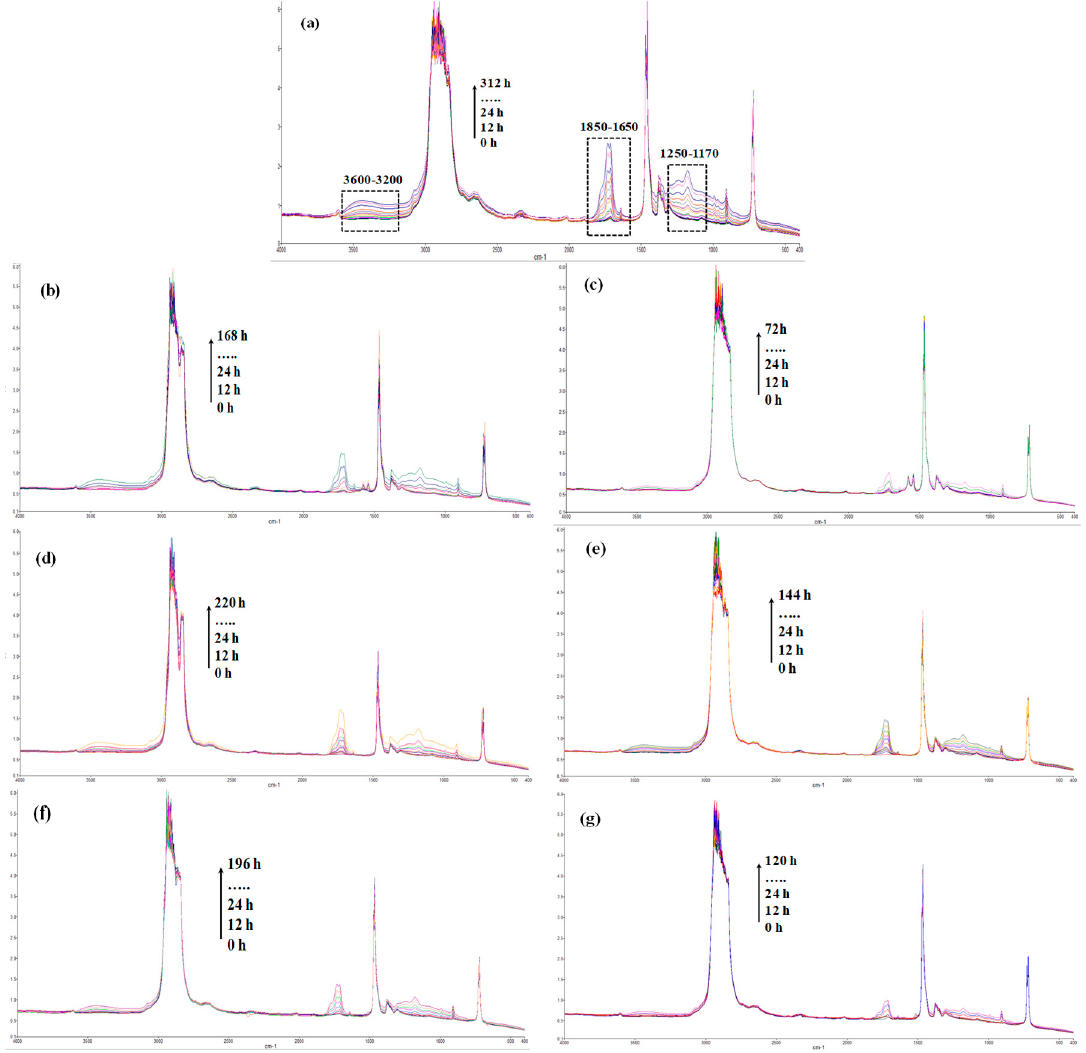
Figure 3. FTIR spectra of neat PE and PE containing different compounds at different photo-oxidation exposure time. ( a ) neat PE; ( b ) 2 wt.% Ca stearate; ( c ) 3 wt.% Ca stearate ;( d ) 2 wt.% Vitamin E; ( e ) 3 wt.% Vitamin E; ( f ) 2 wt.% Ferulic Acid; ( g ) 3 wt.% Ferulic Acid.